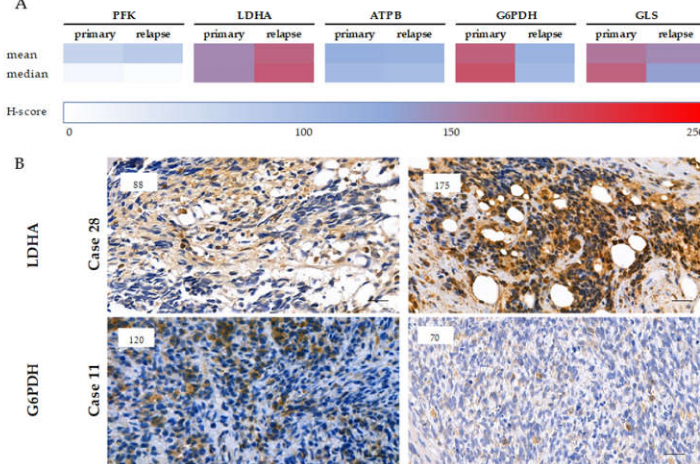
Figure 5. The expression of metabolic markers in paired (primary-relapse) cases. The color scales represent the medians and means of di ff erent metabolic marker H-scores in primary and relapse cases ( A ). LDHA and G6PDH immunohistochemical staining scores of primary and pretreated RMS cases showed remarkable alterations ( B ). The higher expressions of LDHA and the significantly decreased expressions of G6PDH in relapsed cases suggest the increased importance of Warburg-e ff ect instead of pentose-phosphate pathway in relapsed RMSs. DAB (brown) and hematoxylin were used as chromogen and counterstaining, respectively. The numbers in the left upper corner of the pictures refer to the given H-scores. Pictures were taken with CaseViewer 2.3 software (3DHistech Ltd., Budapest, Hungary), the scale bars show 25 µ